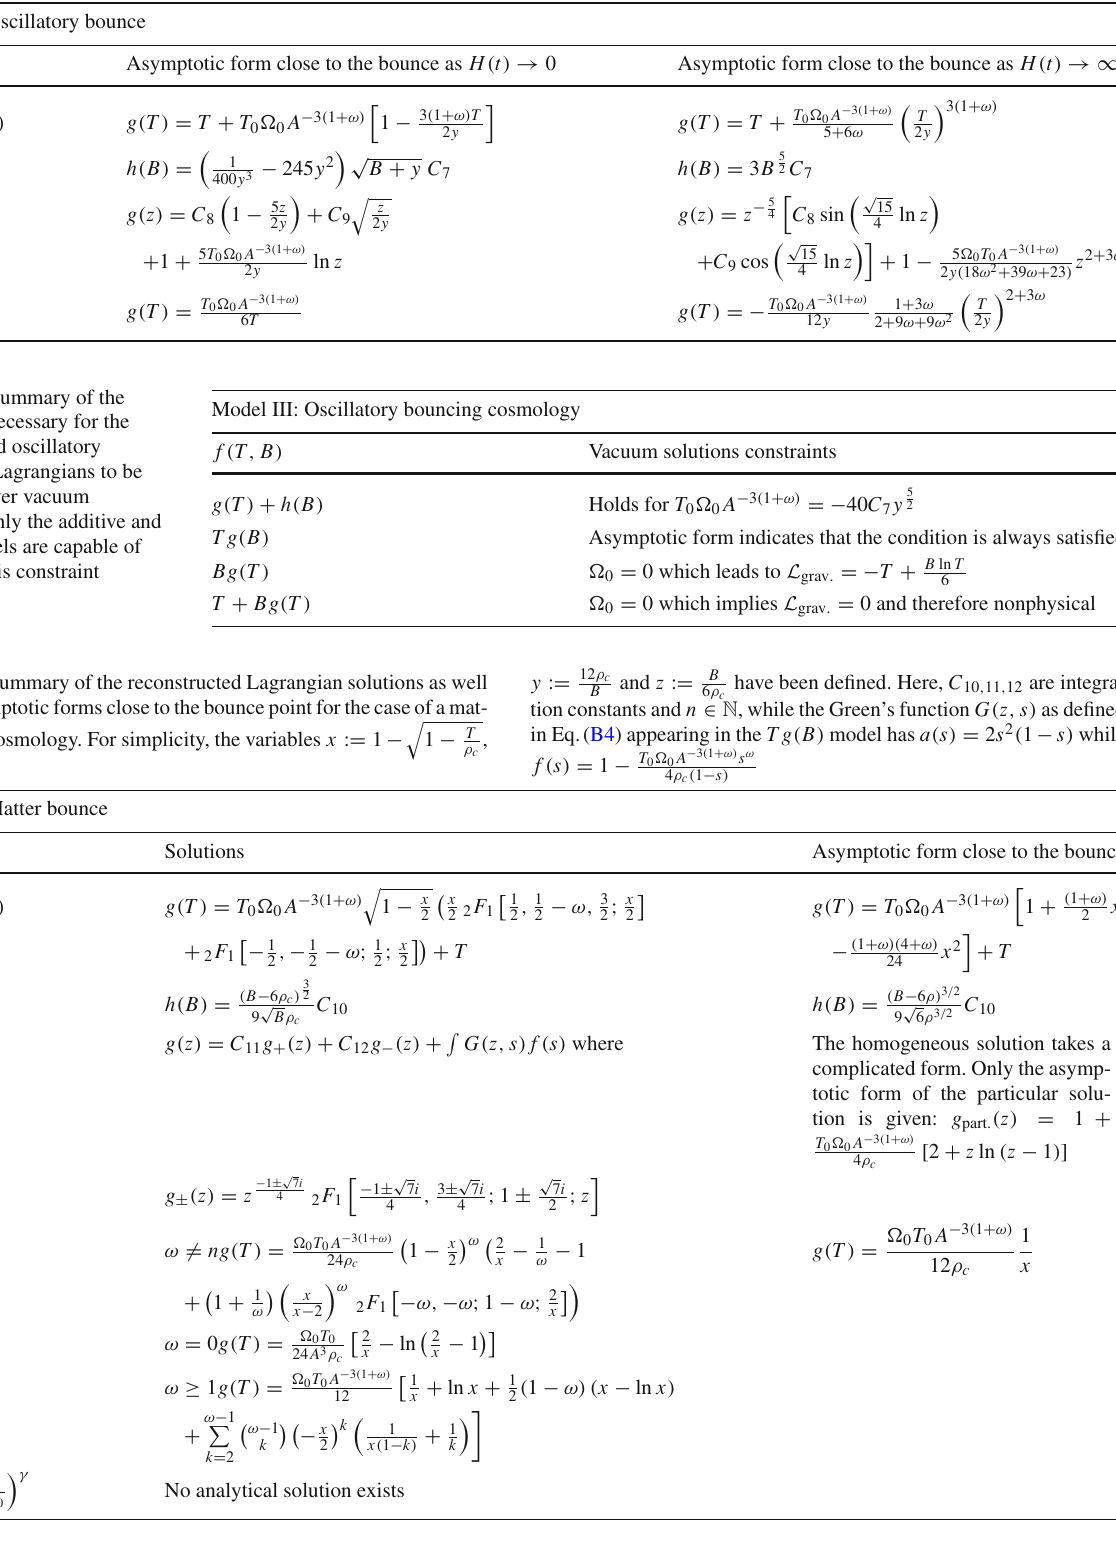
Table 6 A summary of the asymptotic forms of the reconstructed solu- tions for the oscillatory bouncing cosmology described by a ( t ) ∝ (cid:7) (cid:8) Ct for constants C , t ∗ > 0. As this cosmology exhibits two sin 2 t ∗